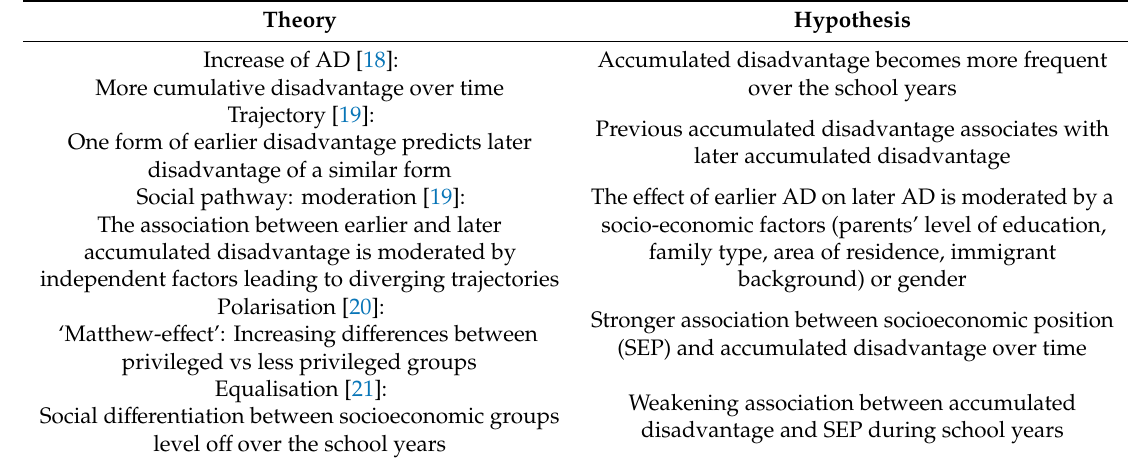
Table 1. Key theories of accumulated disadvantage (AD) and hypotheses derived from them and applied to school years between 13 to 16